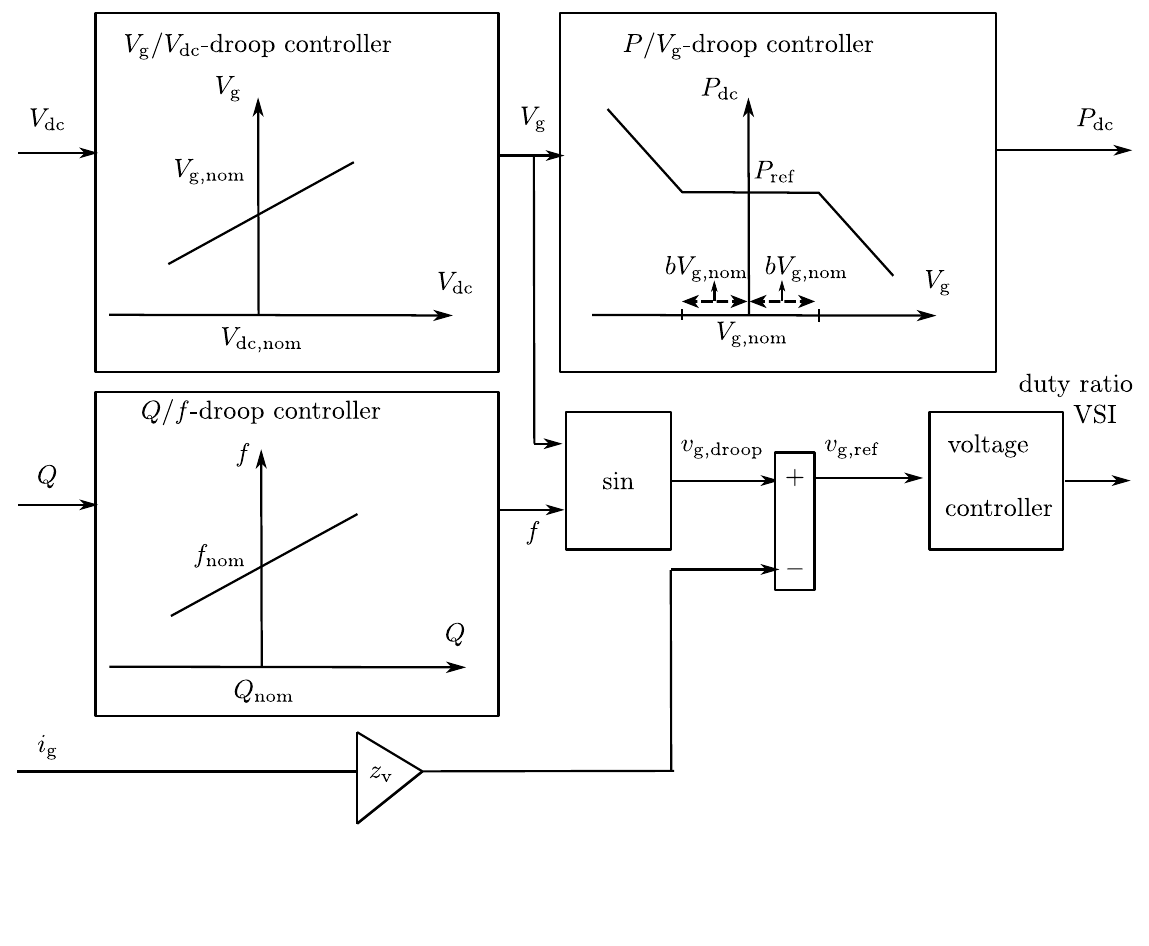
Figure 2. Voltage-based droop (VBD) controller and virtual impedance